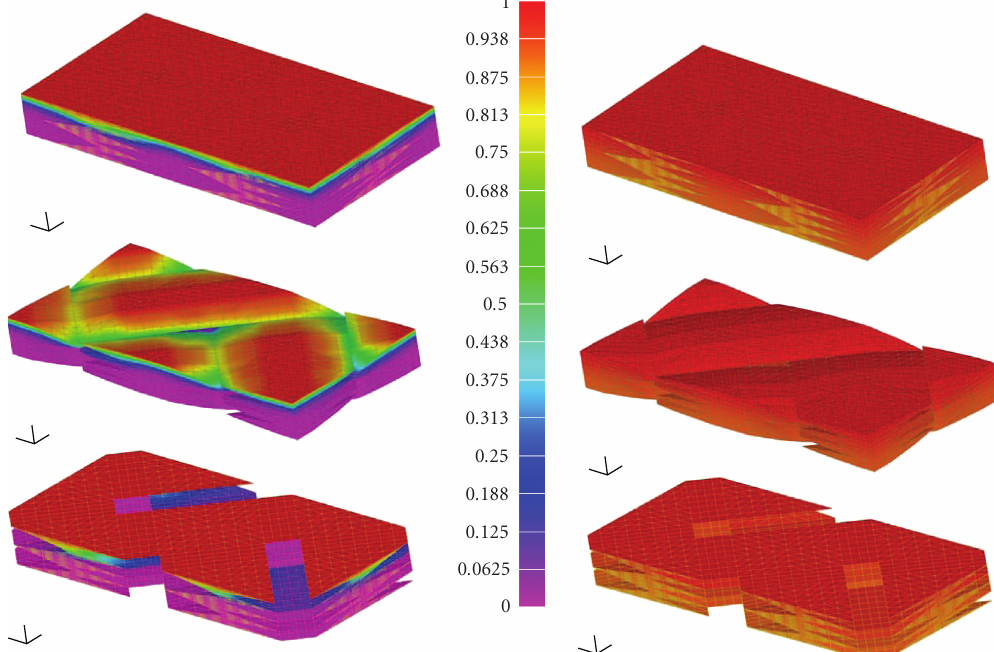
Figure 15: Simulation of the di ff usion process in the RUC of a carbon-braided composite. The image shows the simulation at two di ff erent time steps: at 1 day (left) and at 90 days (right). It is assumed that the transitory regime ends after 90 days.